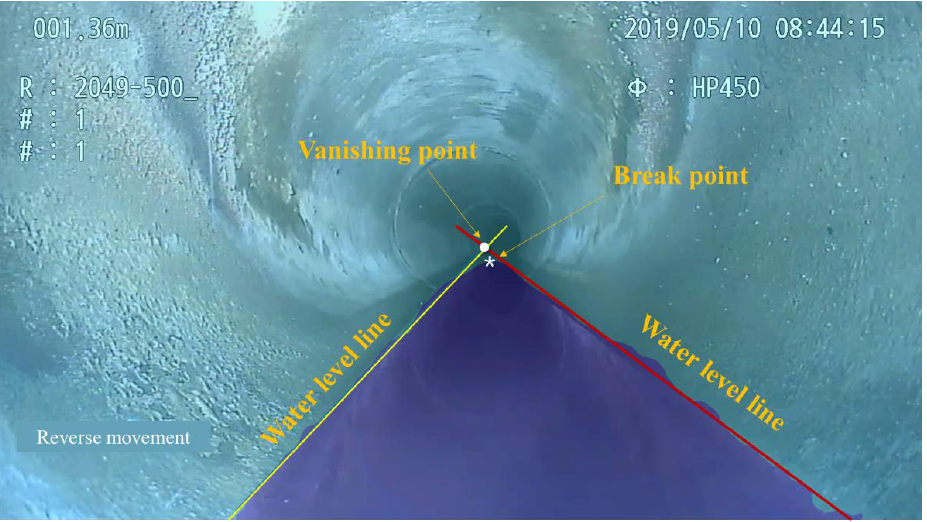
Figure 2. Water level lines analyzed from CCTV footage by deep learning. Figure 3. Water level lines analyzed from CCTV footage by deep learning.